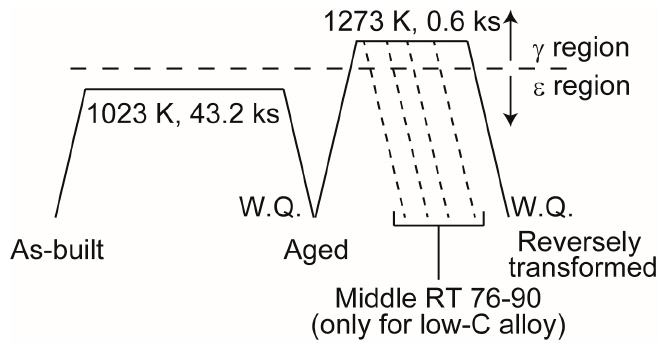
Figure 2. Schematic of the heat treatment process that was used in this study.